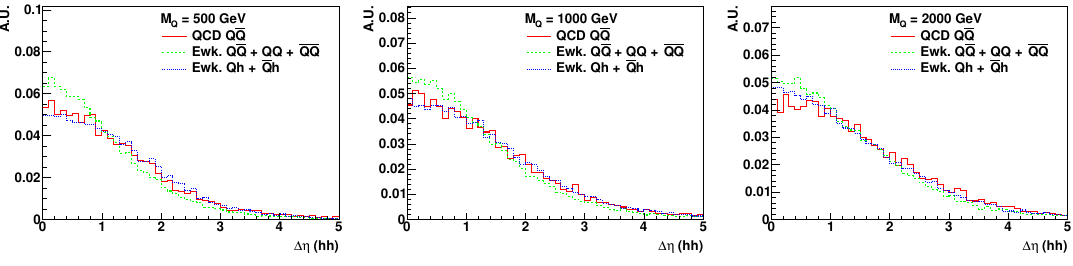
Figure 10 . Same as (cid:12)gure 8 but for the separation in pseudorapidity of the di-Higgs